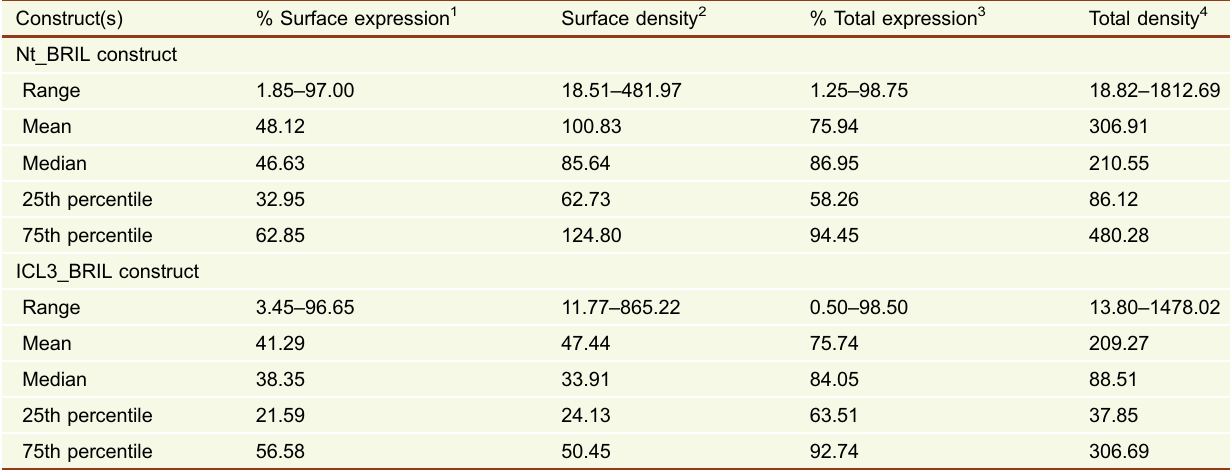
1 Surface expression: The ratio of all the cells expressing the target receptors on the membrane to total cells. 2 Surface density: The ratio of all the fl uorescence of membrane proteins to total cells. 3 Total expression: The ratio of cells expressing the target receptors to total cells. 4 Total density: The ratio of all the fl uorescence to